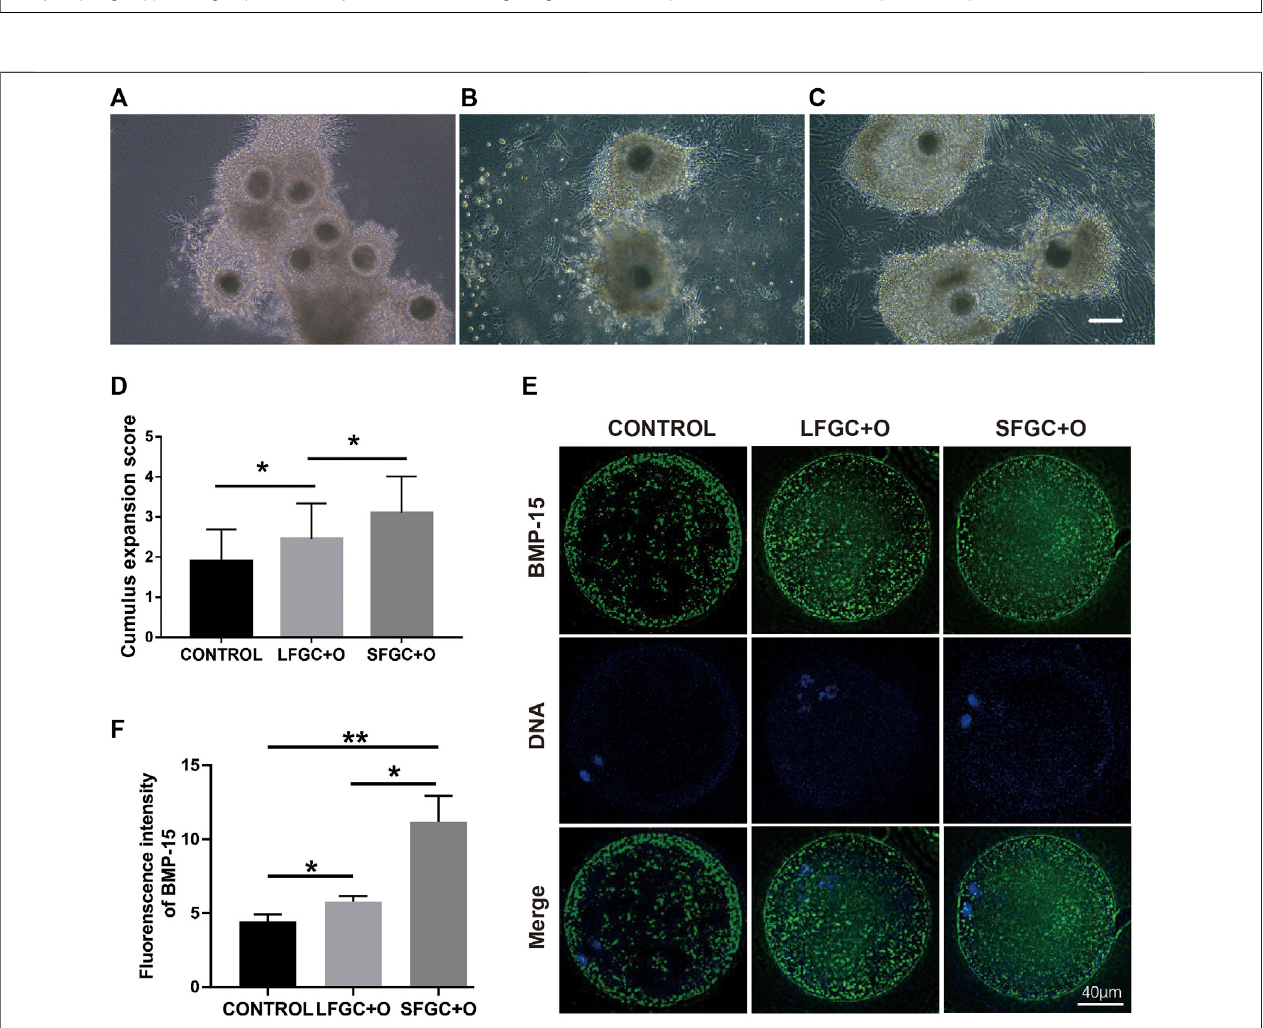
FIGURE 5 | Effects of GC co-culture on cumulus cell expansion and BMP15 expression in mare MII oocytes. Morphology of COCs matured without GCs [CONTROL, (A) ]orwithLFGCs[LFGC+O, (B) ],orSFGCs[SFGC+O, (C) ]for36 hwasexamined. (D) ThedegreeofcumuluscellexpansionwasassessedafterIVM(20 oocytespergroup).Scalebar=150 μ m. (E) Immuno fl uorescencedetectionofBMP15inMIIoocytesderivedfromtheCONTROL,LFGC+O,andSFGC+Ogroups(30 oocytes per group). (F) Average optical intensity was measured using ImageJ. Values are presented as means ± SEM. * p < 0.05, ** p < 0.01.